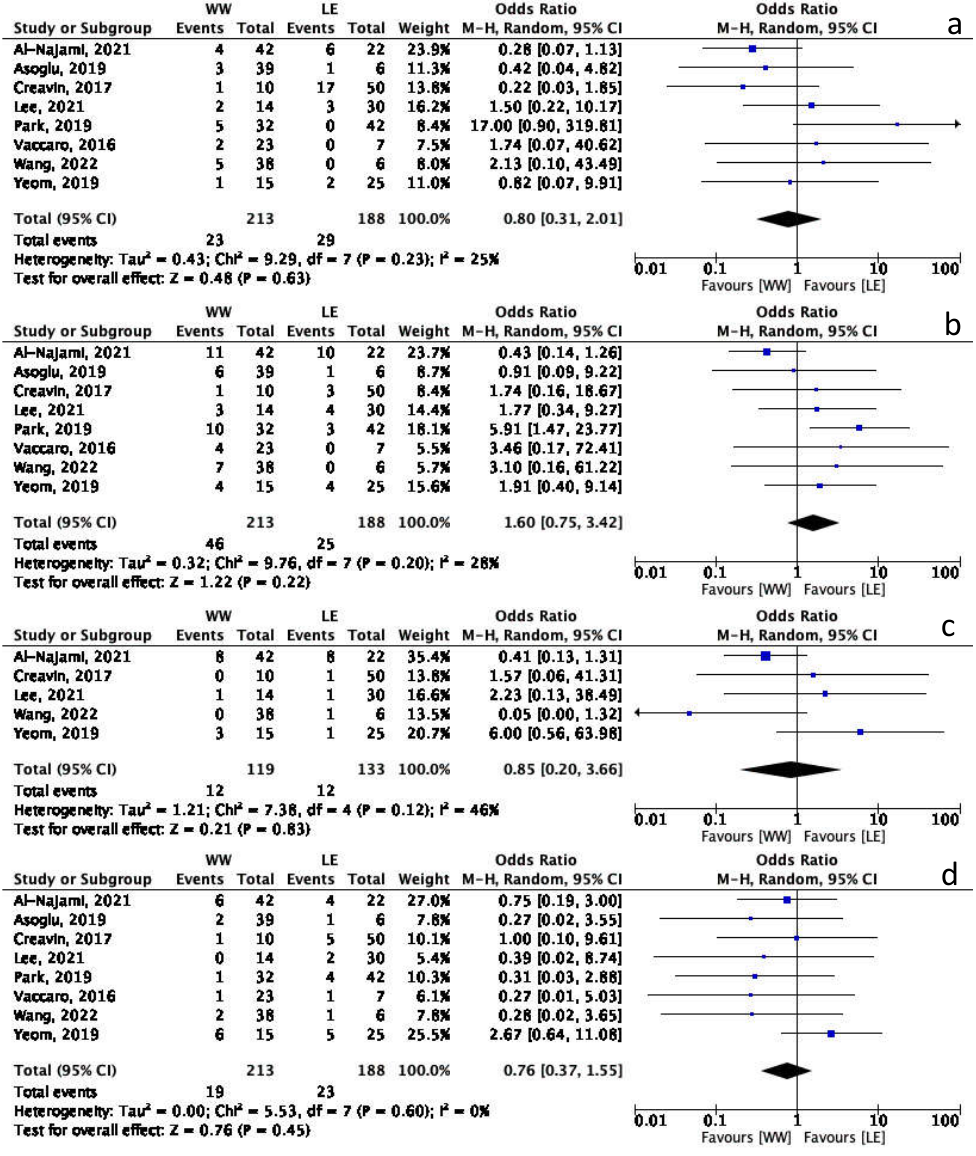
Figure 2. Meta-analysis Forest plot. ( a ) Rectum-preservation. ( b ) Local disease. ( c ) Locoregional failure. ( d ) Distant recurrence.